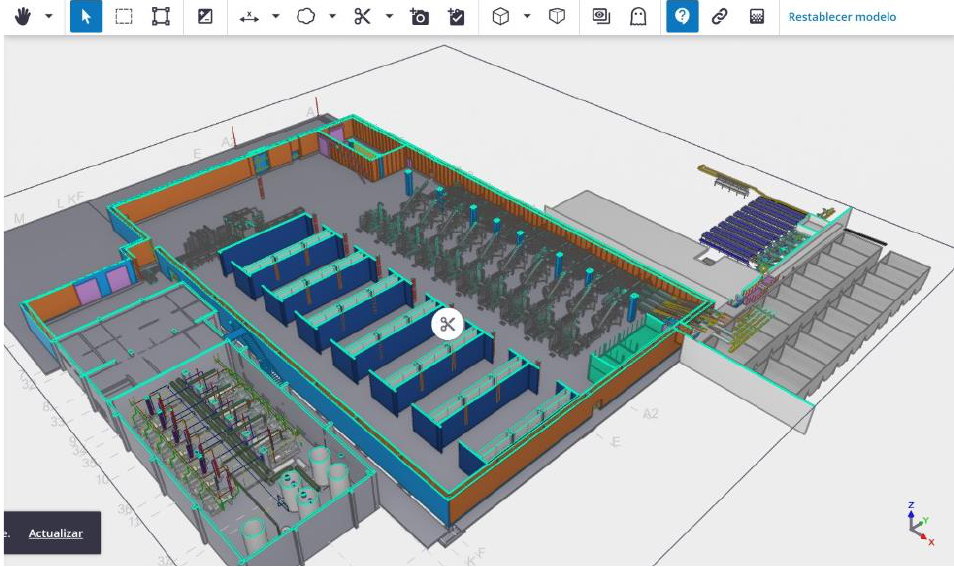
Figure 8. Fish processing plant by the VVL engineering company.